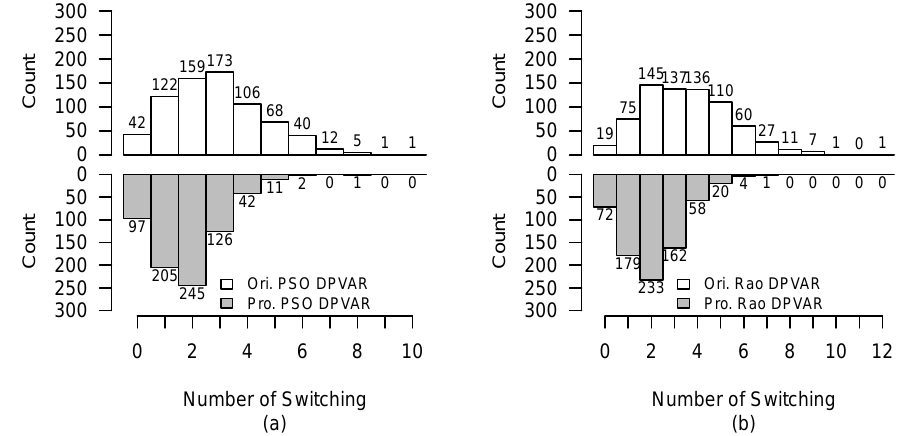
Figure 28. Comparison of switching operation of original-reconfigured and proposed-reconfigured PV arrays under Case 2 with lagged time. ( a ) PSO-reconfigured PV array. ( b ) Rao-reconfigured PV